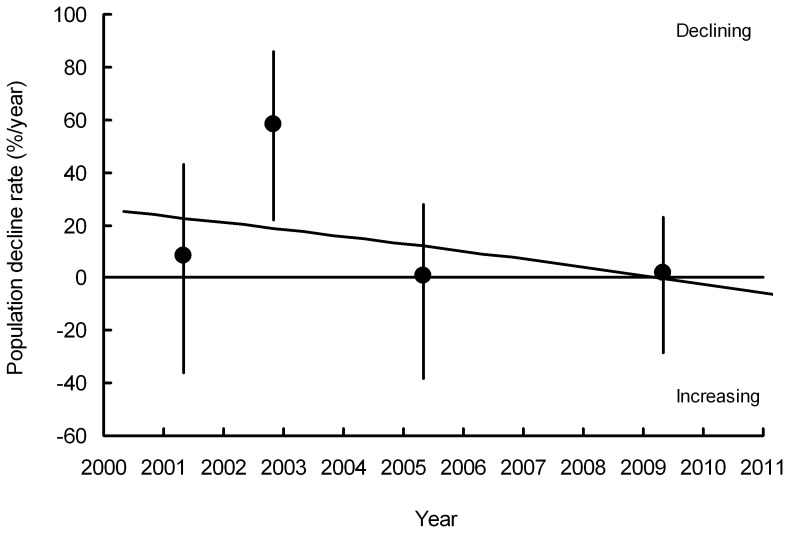
The rate of population decline (% per year) of Gyps indicus and G. tenuirostris combined in India.Circles show average annual rates between each pair of consecutive surveys with their 95% bootstrap confidence limits (vertical lines) plotted midway between the dates of the two surveys. The line shows the first derivative of the quadratic log-linear population trend fitted to the survey data for the period 2000–2011.